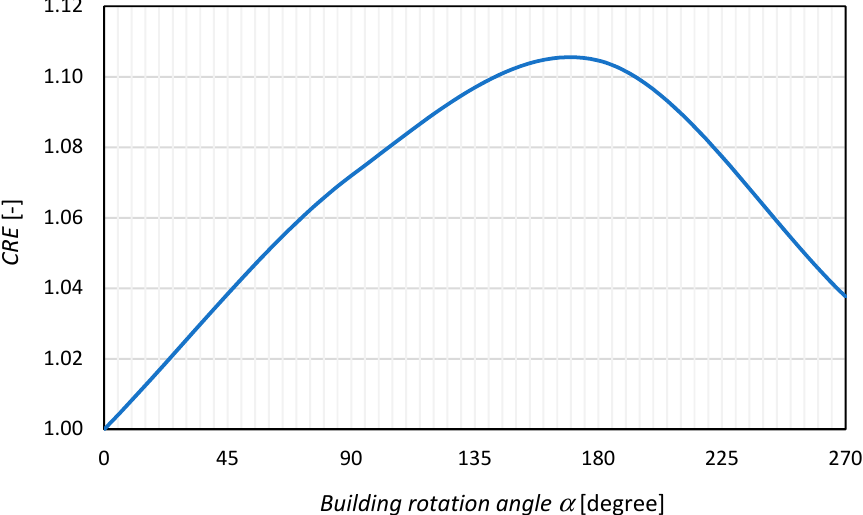
Figure 11. Dependence of the final energy demand on the building’s orientation towards the directions of the world.